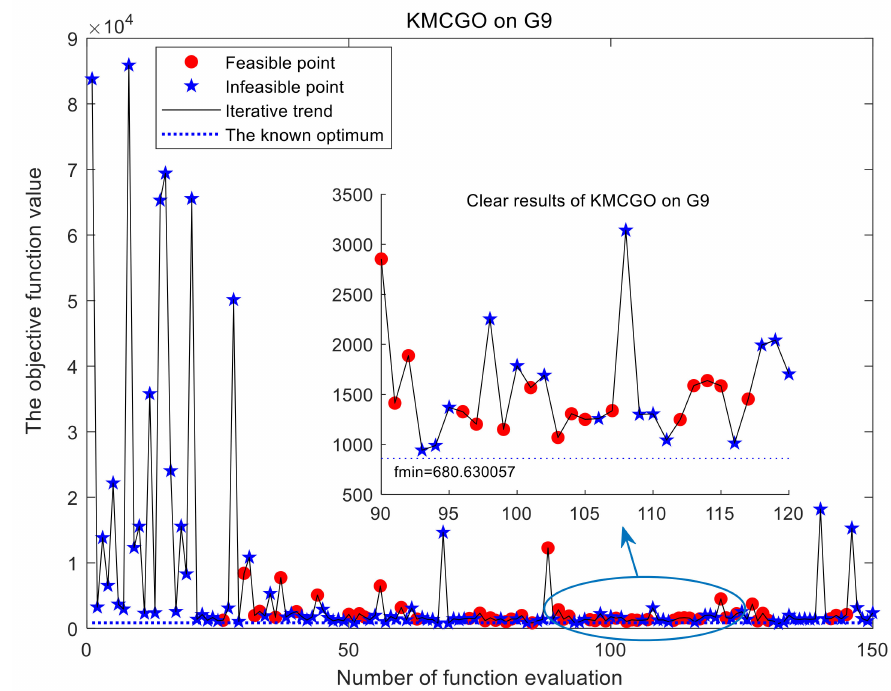
Figure 10. Iteration result of the G9 function.